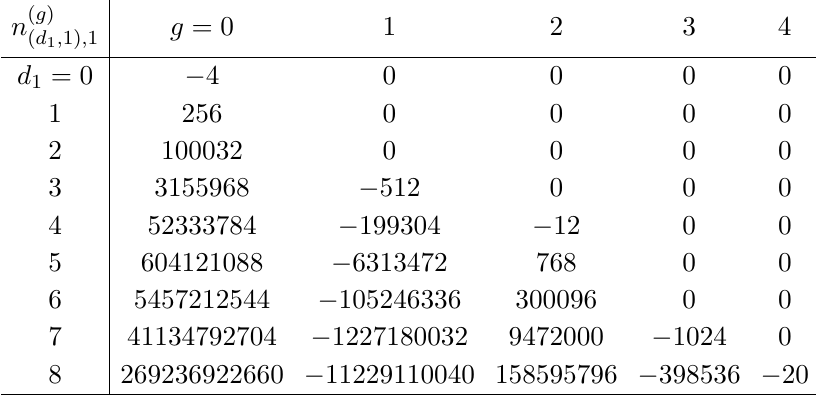
Table 33 . Base degree 1 Gopakumar-Vafa invariants for X (4)